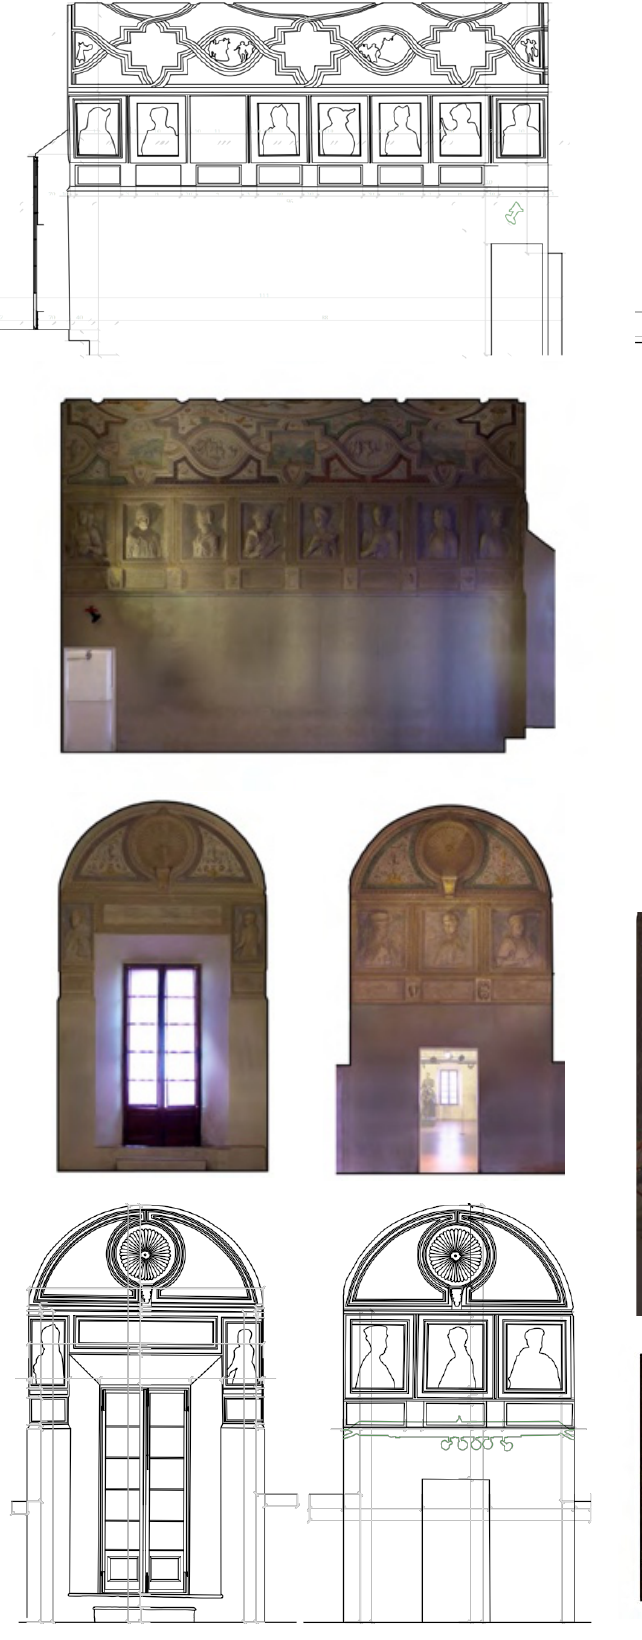
Figure 13. Sections of the room (by photos and by lines) coming from Photoscan projections